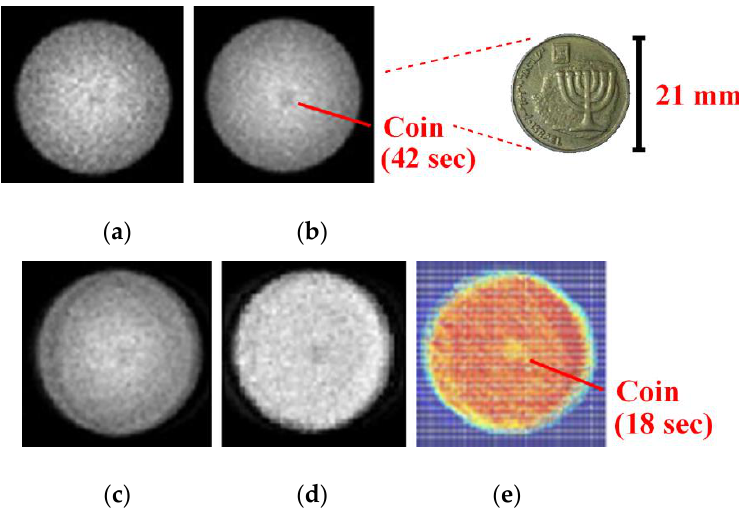
( c ) Figure 7. Gamma radiation nuclear imaging system’s results: ( a ) the reference image from a one pinhole system; ( b ) the captured image of the 1-D pinhole array system; ( c ) The reconstructed image of the 1-D pinhole array system with better sensitivity efficiency (improvement factor of 2.333) and better SNR.